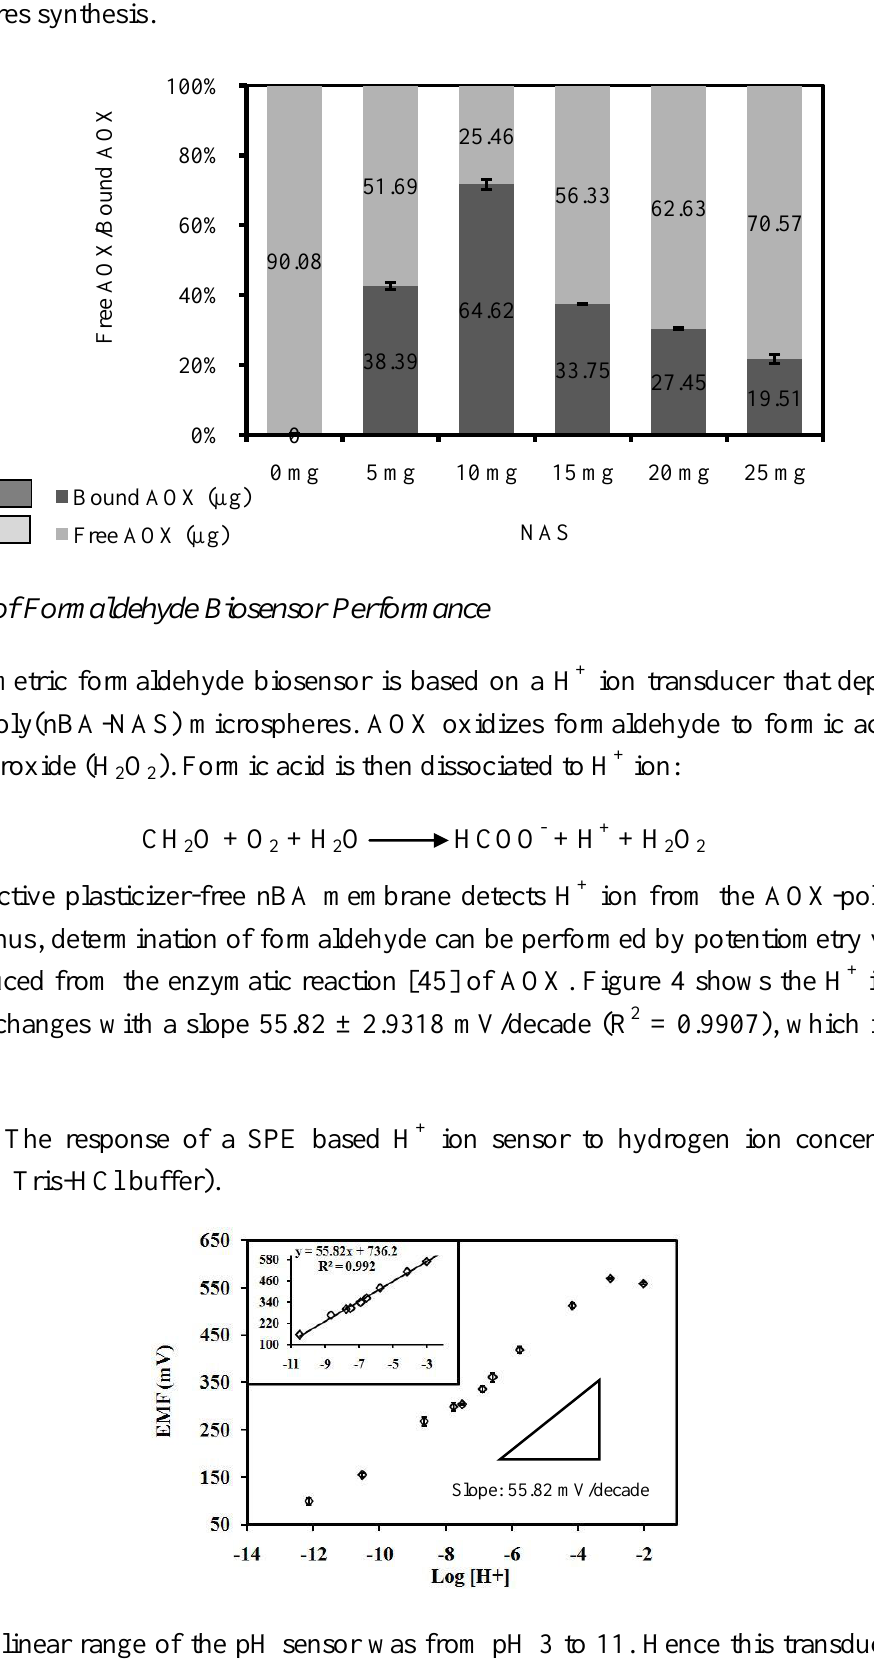
Figure 3. The amount of bound AOX determined according to the amount of NAS used for microspheres synthesis.